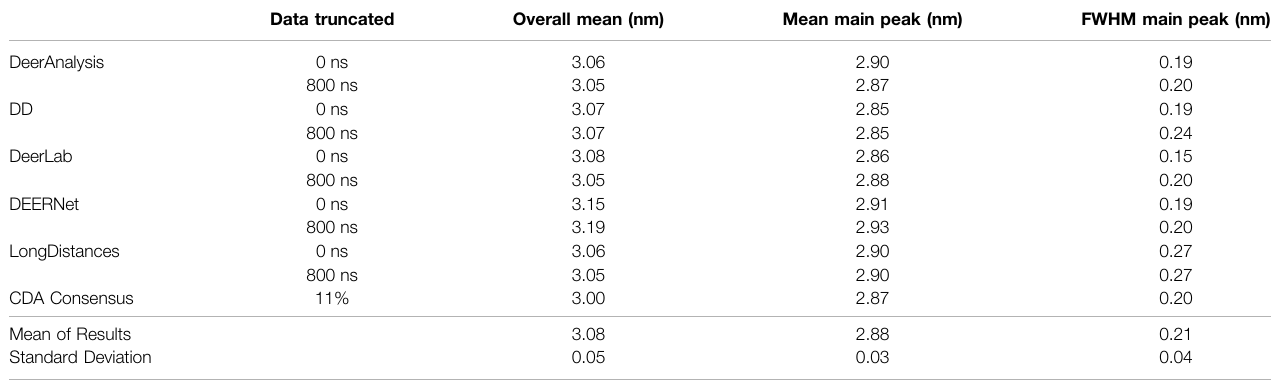
TABLE 6 | Results from each program for the AGAO data, with both 0 ns cut and 800 ns cut.